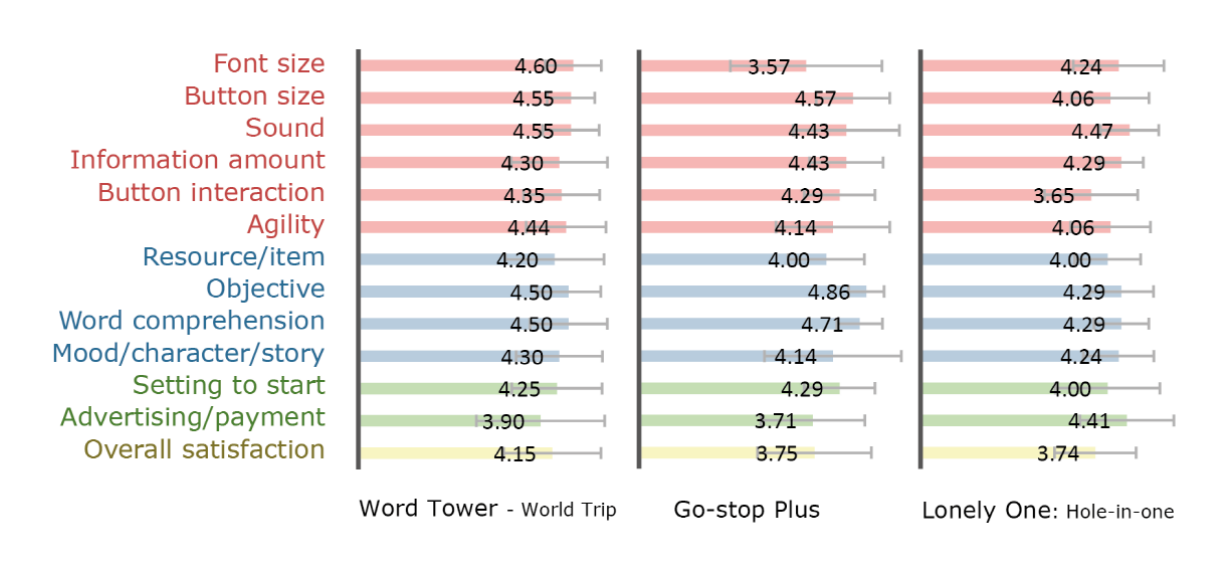
Figure 4. Satisfaction levels in games played by the older adult